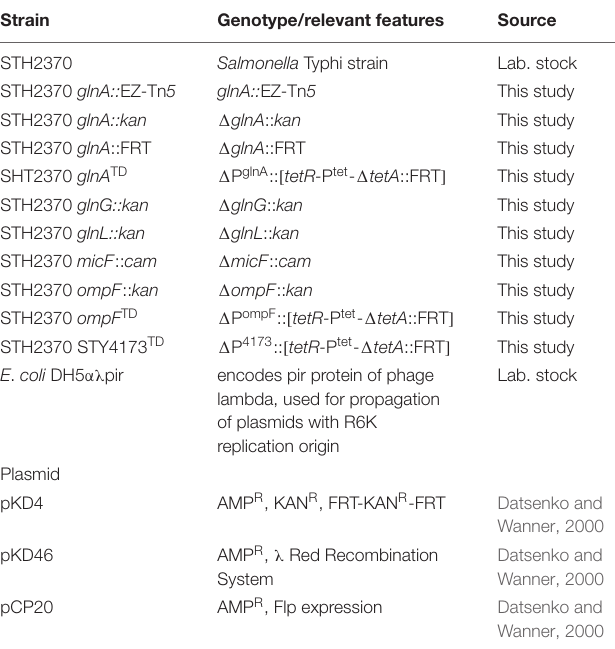
TABLE 1 | Strains and plasmids used in this